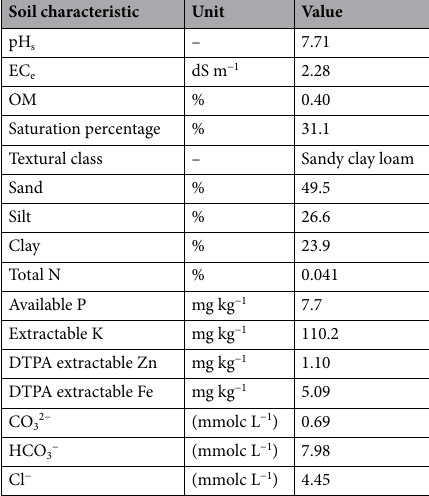
Table 1. Pre-sowing analysis of the soil used for present